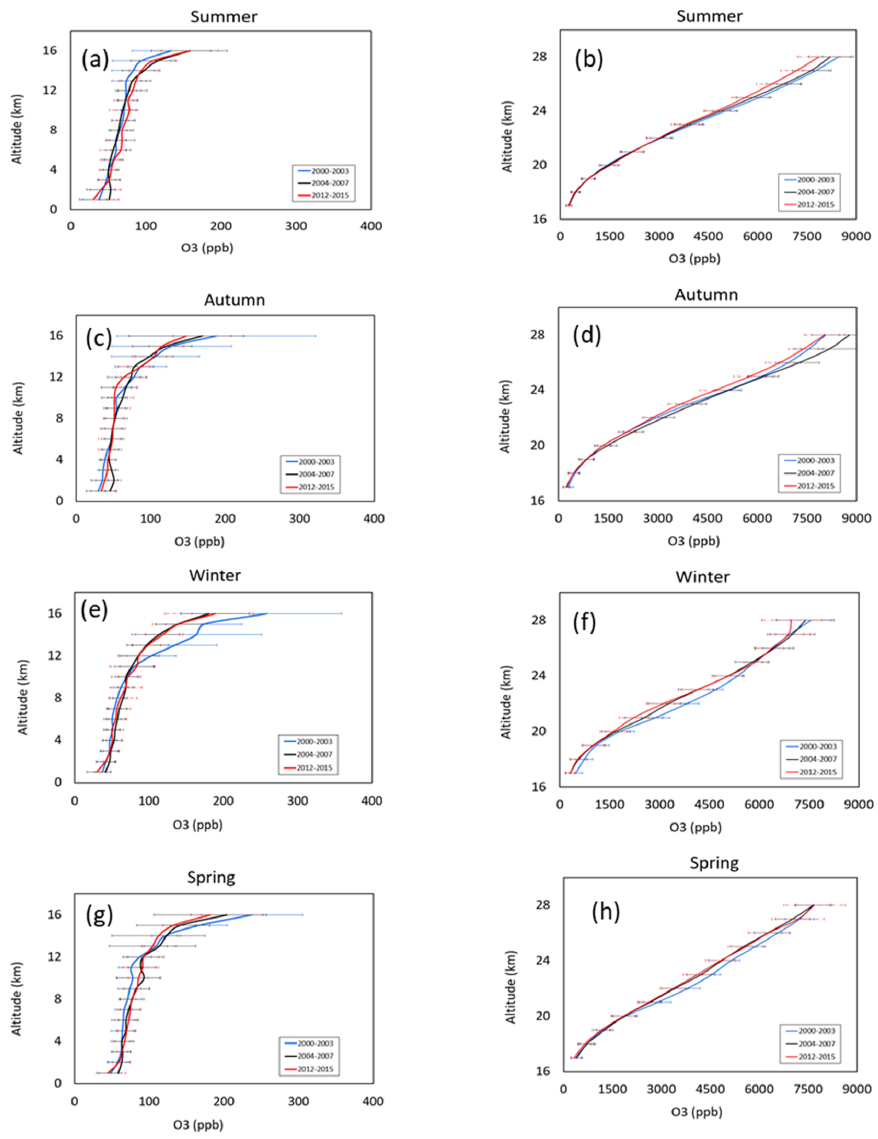
Figure 3. Ozone seasonal profiles for the troposphere ( a , c , e , g ) and stratosphere ( b , d , f , h ). Blue line indicates 2000–2003 averages, black line indicates 2004–2007 averages and red line indicates 2012–2015 averages. The error bars indicate the standard deviation. Table 1. Summary of high ozone (ppb) events statistics using 95th percentile and potential vorticity (2 PVU) as